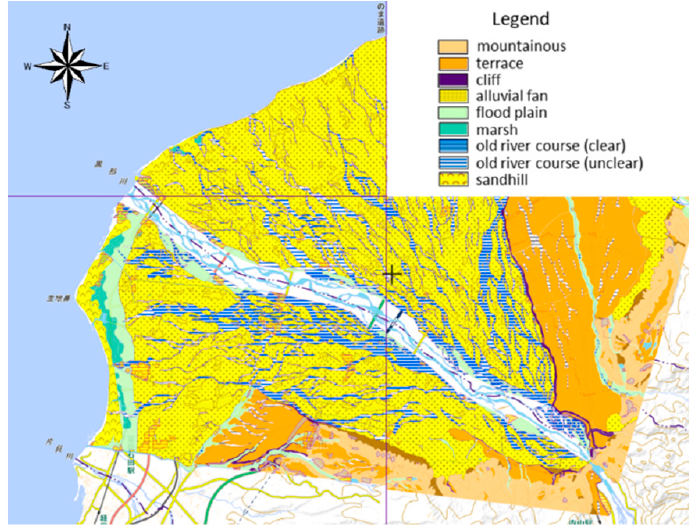
Figure 4. Landform classification map for flood control. In the identification of landmarks, some subjective judgment is unavoidable, but the results shown in Figure 5a were obtained by aiming for overall consistency. In the figure, the blue lines are stream paths and the red lines are the 18th-C levees that were drawn in Map (a) in 1785. The red lines in Figure 5b indicate the 19th-C levees that were drawn in Map (b) in 1894. Many branch streams were cut off by the 19th-C levees and, as a result, the river flow was finally concentrated in a narrow band bounded by levees.